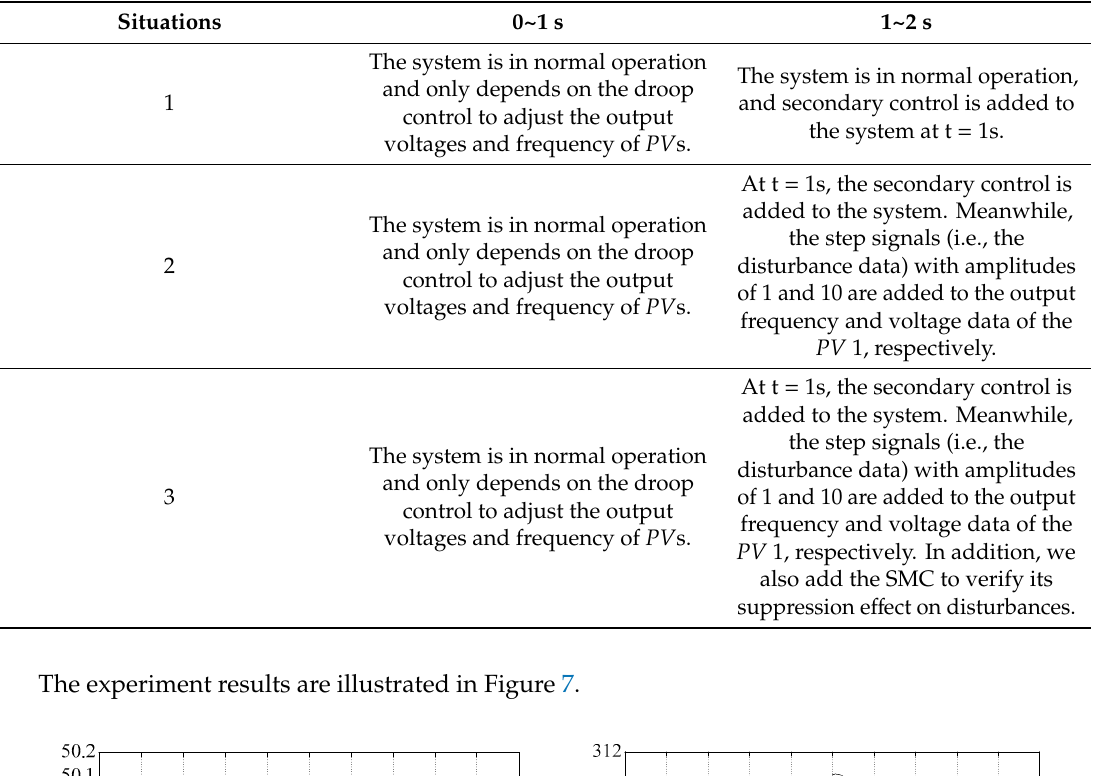
Table 2. The involved communication data and control signal in the secondary control progress.